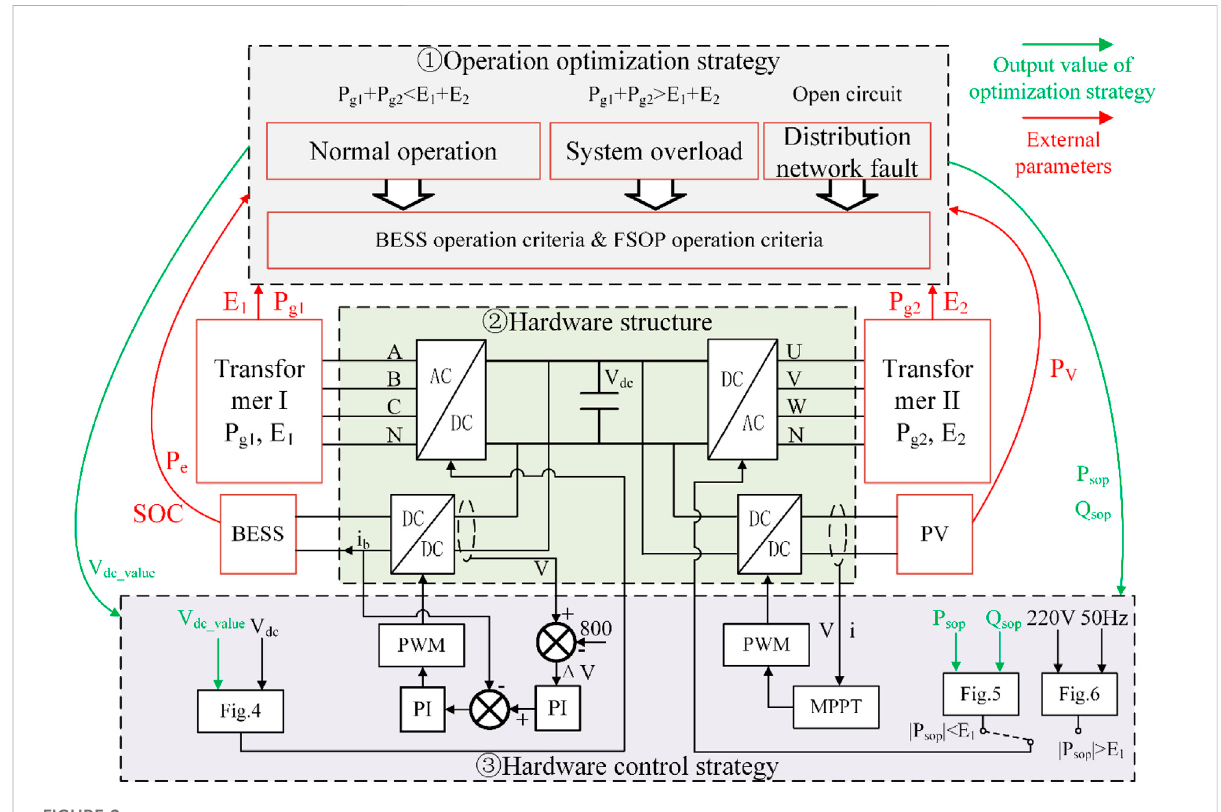
FIGURE 2 System control architecture